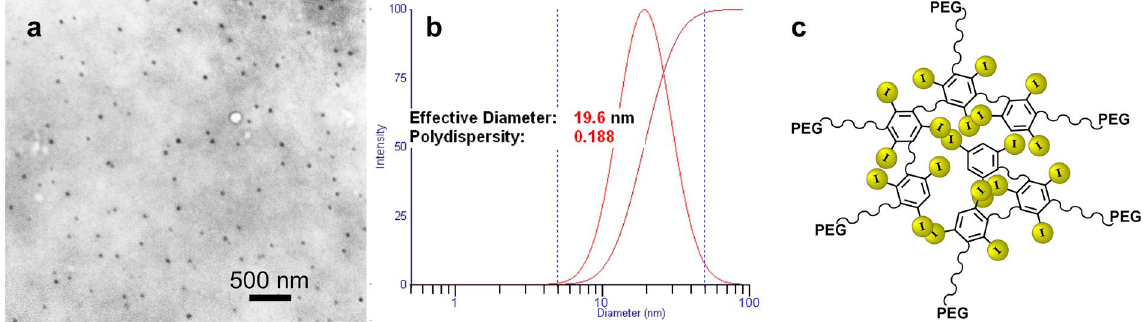
Figure 1. Electron micrograph ( a ), dynamic light scattering ( b ), and schematic ( c ) of the iodine